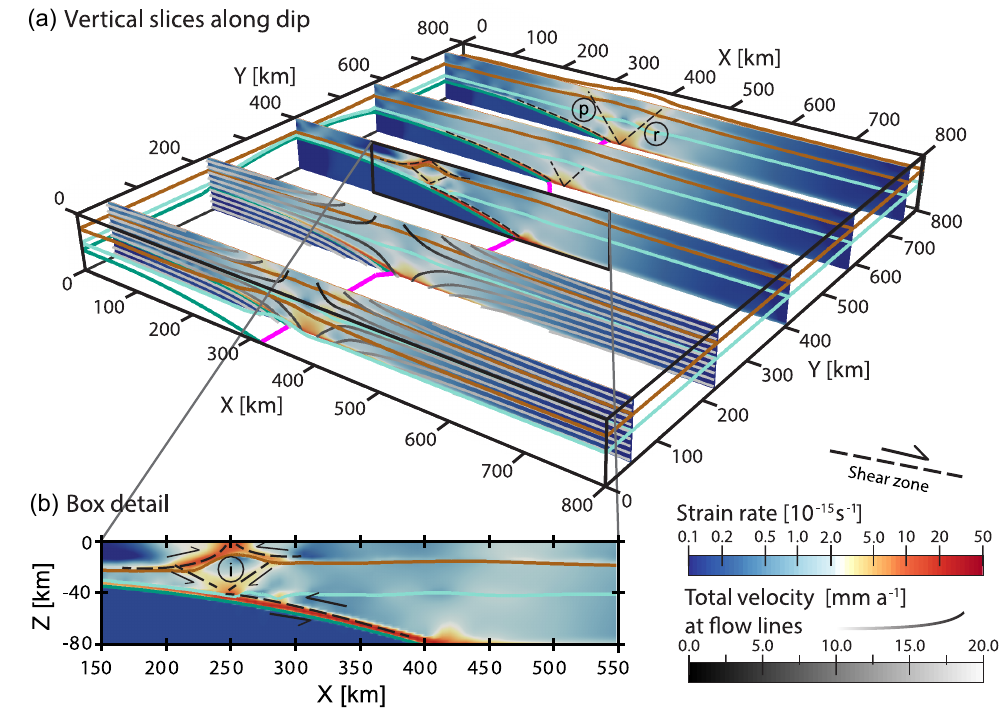
Figure 3. Vertical slices along dip after 4.0Myr simulation time showing the second invariant of the strain rate tensor and particle trajectories for the indenter geometry under half-advance boundary conditions. Brown, light green, and dark green lines denote the material layer boundaries between upper crust, lower crust, and lithospheric mantle, respectively; magenta marks the S line. Pro- and retro-shear zone are labeled (p) and (r), respectively, while indenter detachment is labeled (i). Note that results are symmetrical about the y = 400km plane. (a) Slices along dip in 3-D: deformation at the front and back is weakly localized in two symmetrical shear zones rooting to the S line, forming a lithospheric-scale pop-up structure. Above the indenter, shortening is accommodated by a newly formed basal detachment replacing the steeply dipping shear zones. (b) Detail inset shows the strain rates along the central